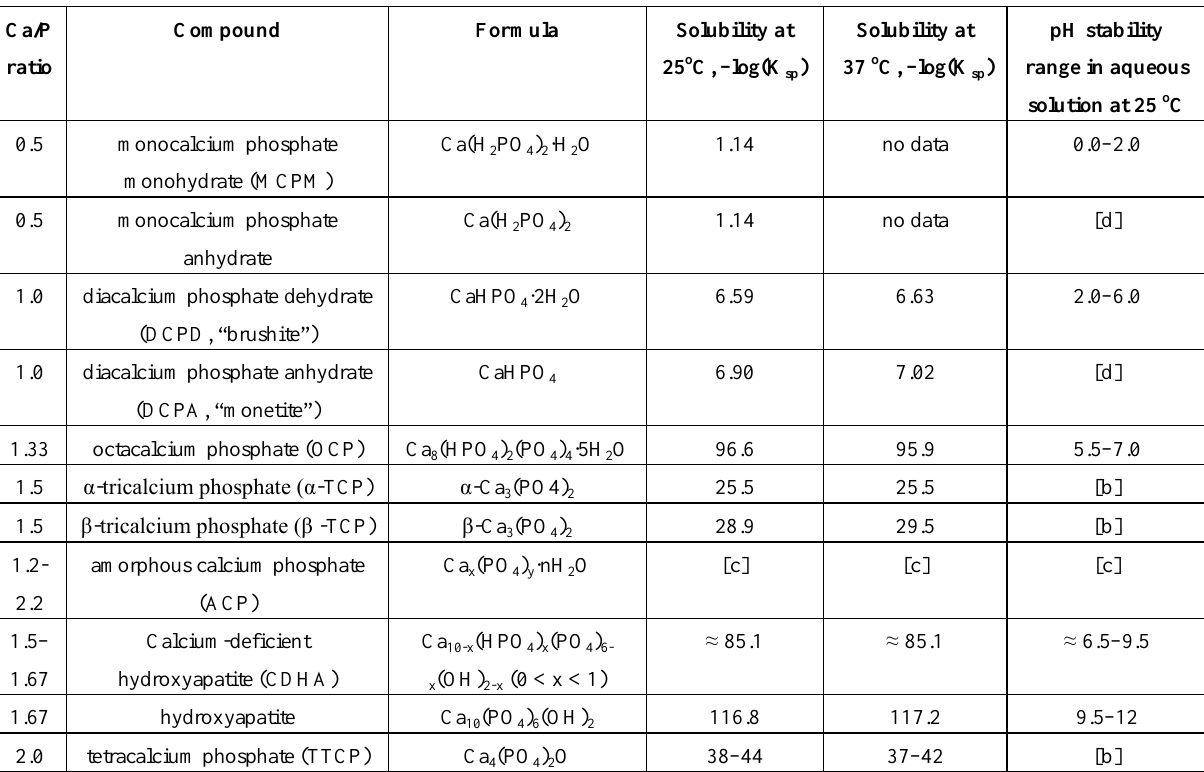
Table 3. Properties of the biologically relevant calcium orthophosphate. (Reproduced with permission from Prof. Epple, M.